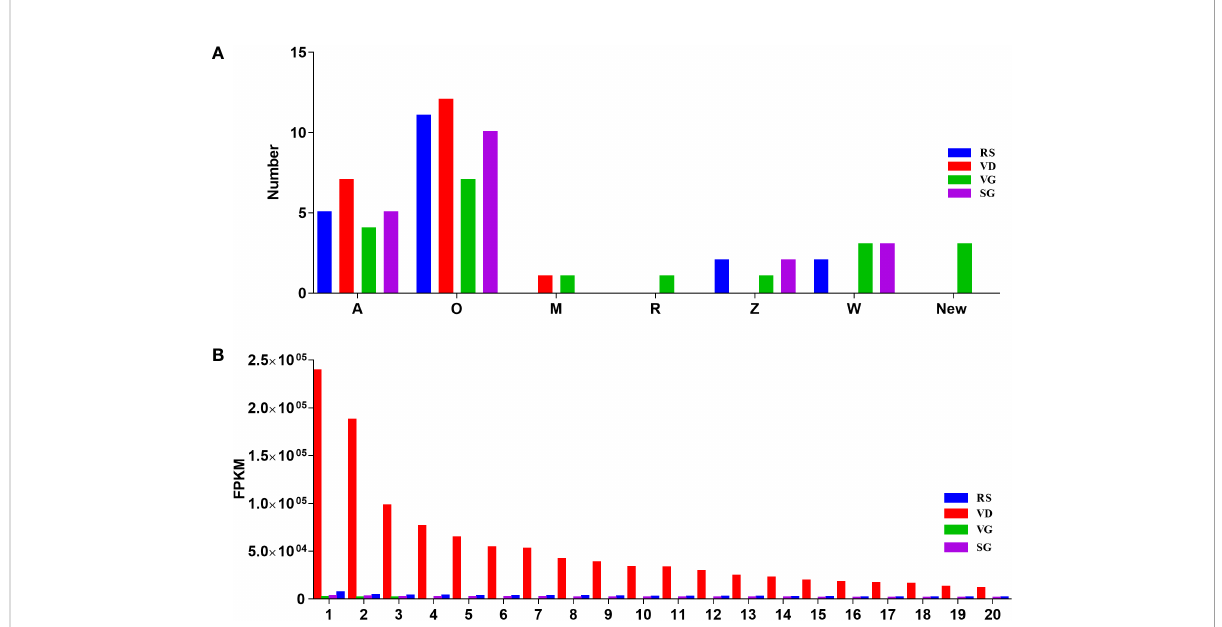
FIGURE 3 The top 20 conotoxins with the highest transcription values from the four transcriptome datasets. (A) subdivision of conotoxin superfamilies from the VD, VB, and SG datasets. (B) Comparison of the FPKM values for individual conotoxin within each